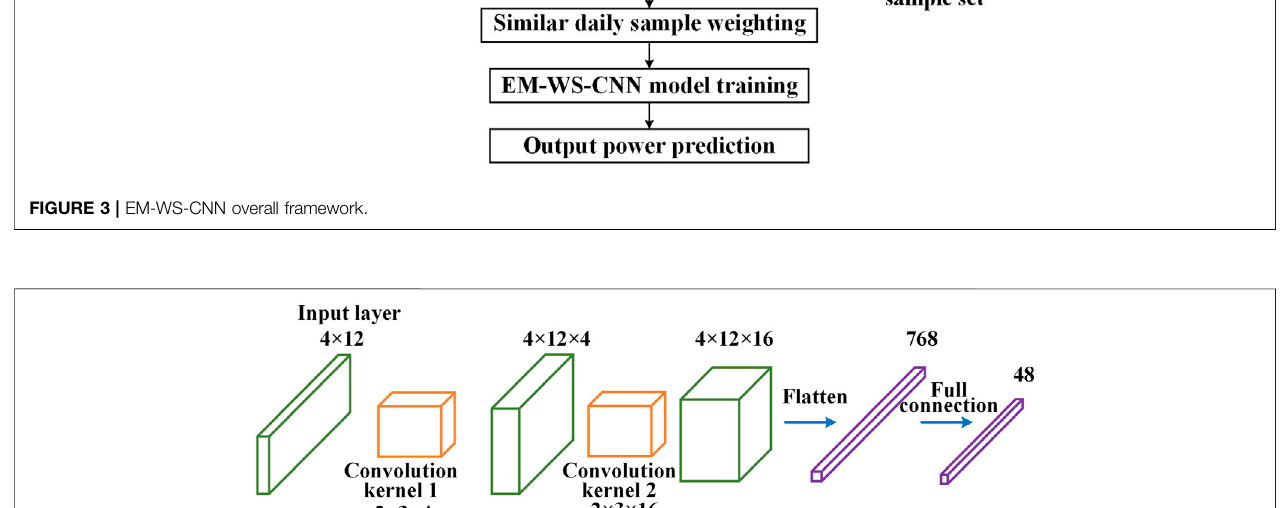
FIGURE 4 | Structure of